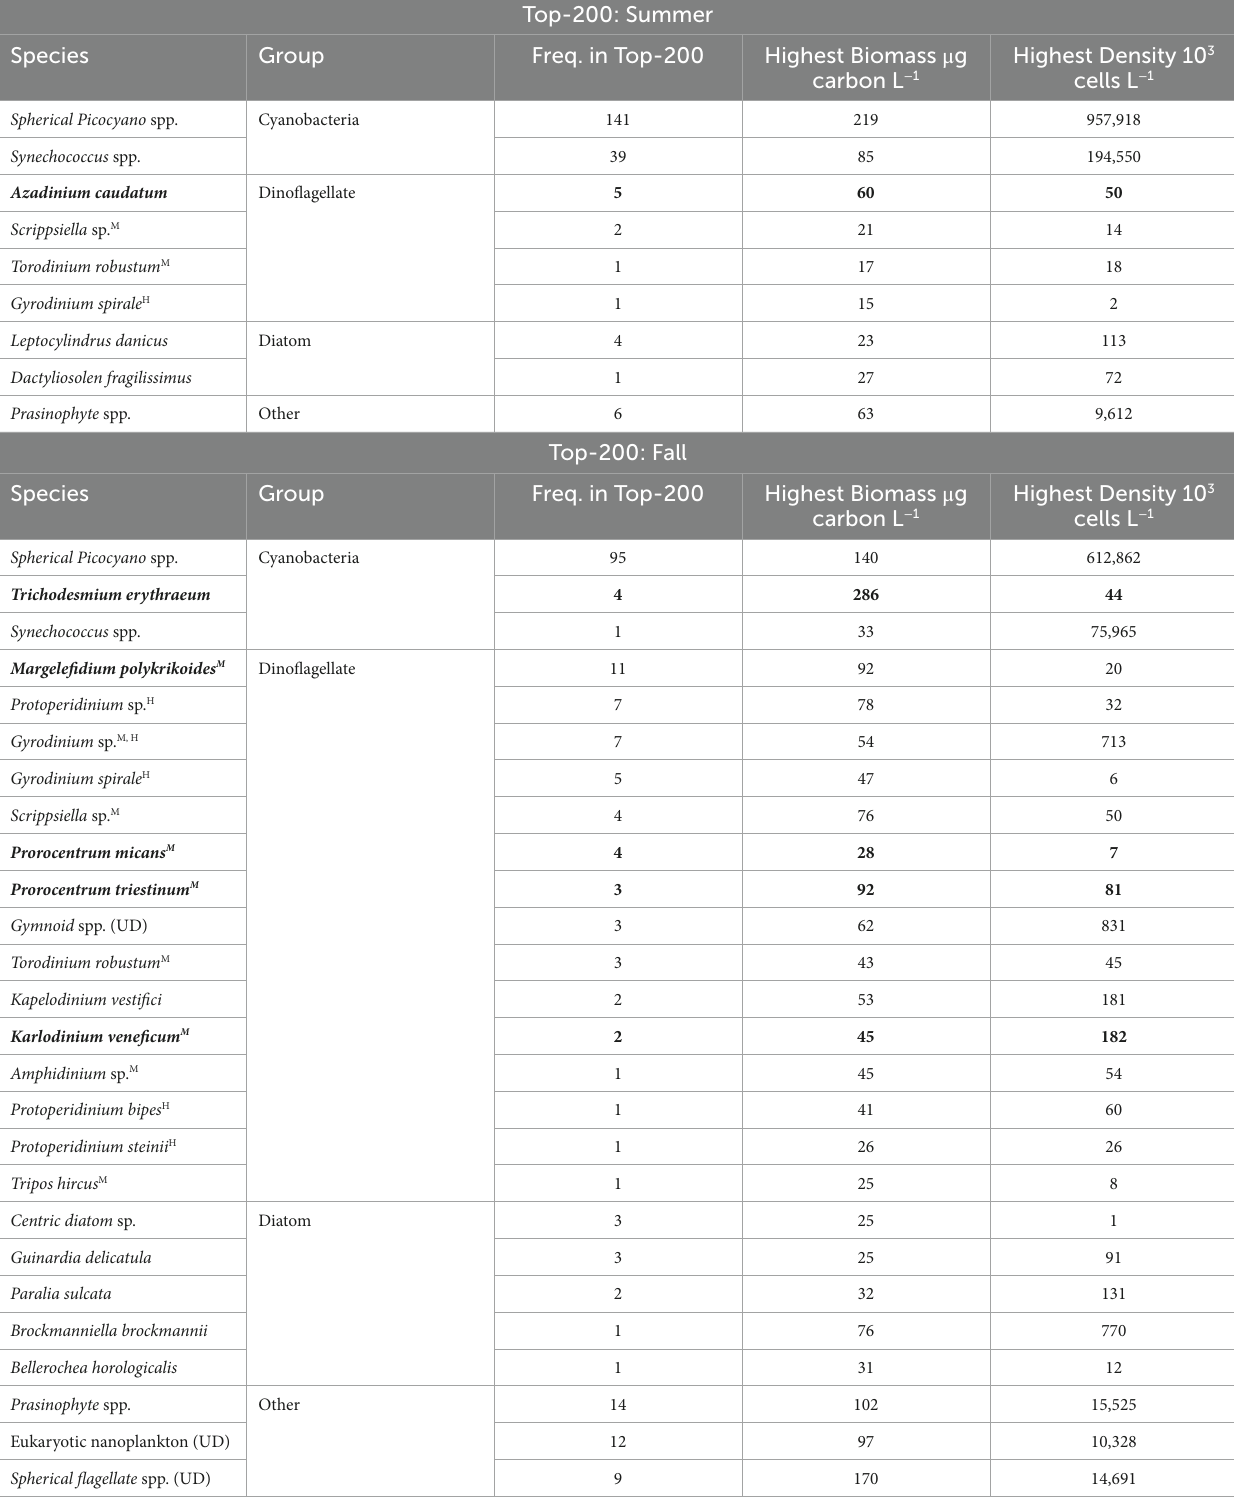
TABLE 4 Top-200 list of highest biomass of individual taxonomic groups for the summer and fall. Top-200: Summer Species Group Freq. in Top-200